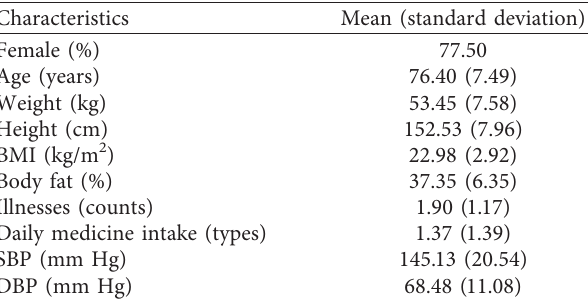
Table 1: Demographic and health characteristics of the sample ( N �